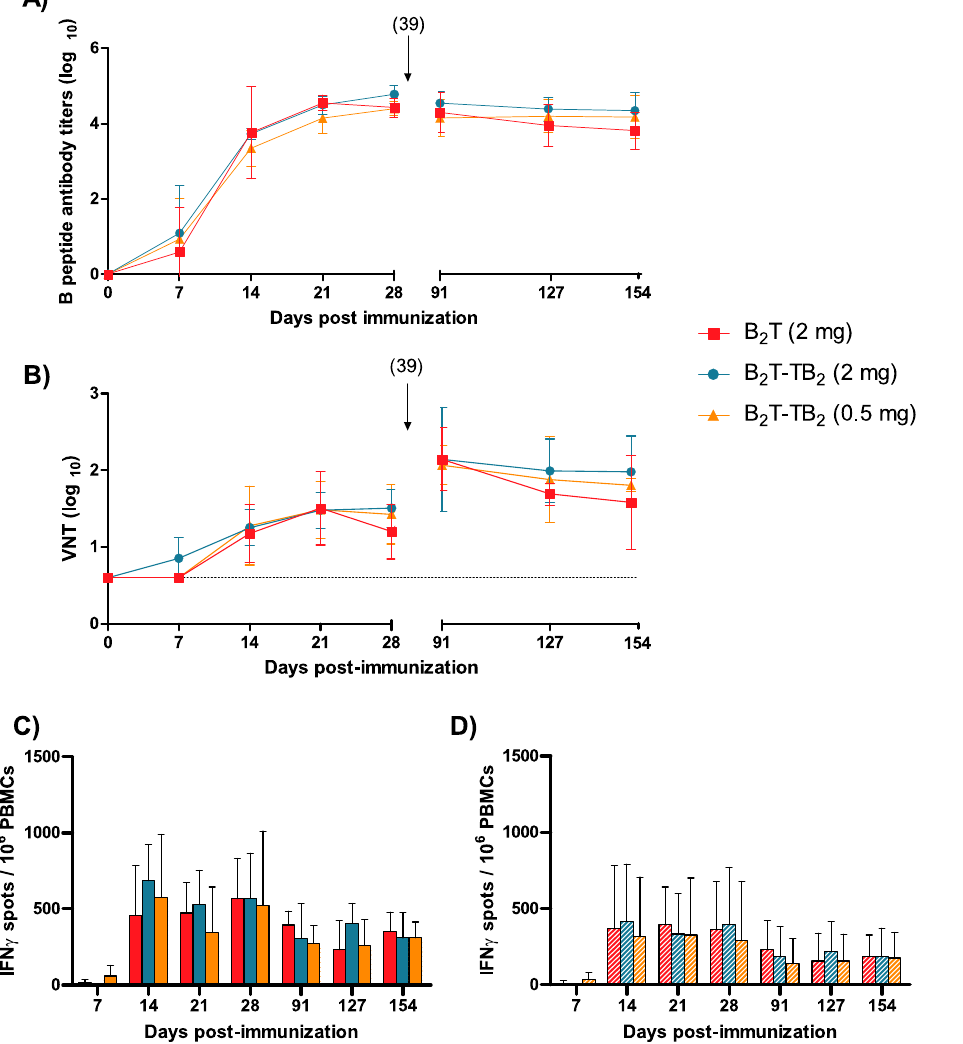
Figure 3. Long-term response and dose effect of B 2 T-TB 2 (click) dimer. Time-course of the specific immune responses against FMDV in pig sera collected on the indicated days post-immunization (7, 14, 21, 28, 91, 127, and 154 pi). ( A ) Antibody response analyzed by ELISA. Each point depicts mean antibody titers (calculated as described in Experimental Section) ± SD for each group of pigs. ( B ) Virus neutralization titers expressed as the reciprocal log10 of the last serum dilution that neutralized 100 TCID50 of FMDV O UKG / 11 / 2001. Each symbol represents the value for an individual pig. Horizontal lines indicate the geometric mean for each animal group. Differences were not statistically significant. Arrows show the day of boost and dotted line indicates the detection limit. ( C , D ) Specific T-cell responses measured by an ex vivo IFN- γ ELISPOT. IFN- γ released by PBMCs from pigs stimulated in vitro with the corresponding dendrimer (solid bars) or with T-epitope (striped bars), respectively. The frequency of FMDV-specific IFN- γ secreting cells was determined as detailed in Experimental Section.